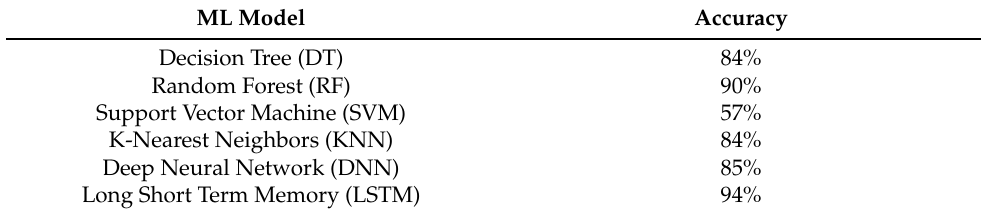
Table 3. Accuracies of ML classifiers for charging speed